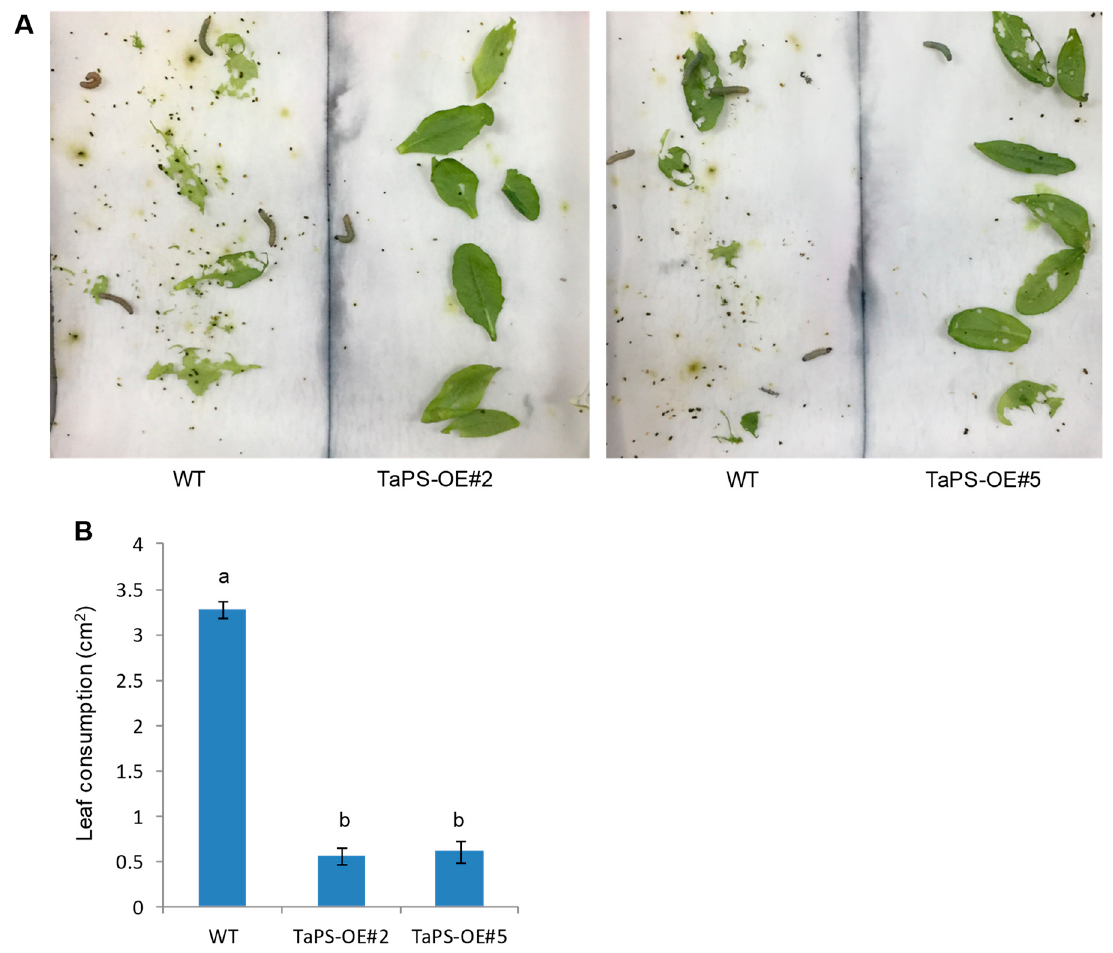
Figure 4. Dual choice assays. ( A ) Arabidopsis leaves fed by beet armyworm larvae for 24 h. Seven pieces of leaves for wild type (WT) or overexpression lines (TaPS-OE) were placed on the opposite side of the same plate. Five larvae were placed at the middle line in each plate. Two independent lines (TaPS-OE#2 and #5) were used for assays; ( B ) leaf consumption of beet armyworm larvae on WT and transgenic Arabidopsis leaves. The consumed leaf area (cm 2 ) was calculated based on leaf images before and after feeding with analysis by Image J. The lowercase letters indicate significant difference (Tukey HSD test, p < 0.05). Error bars indicate SE ( n = 3).